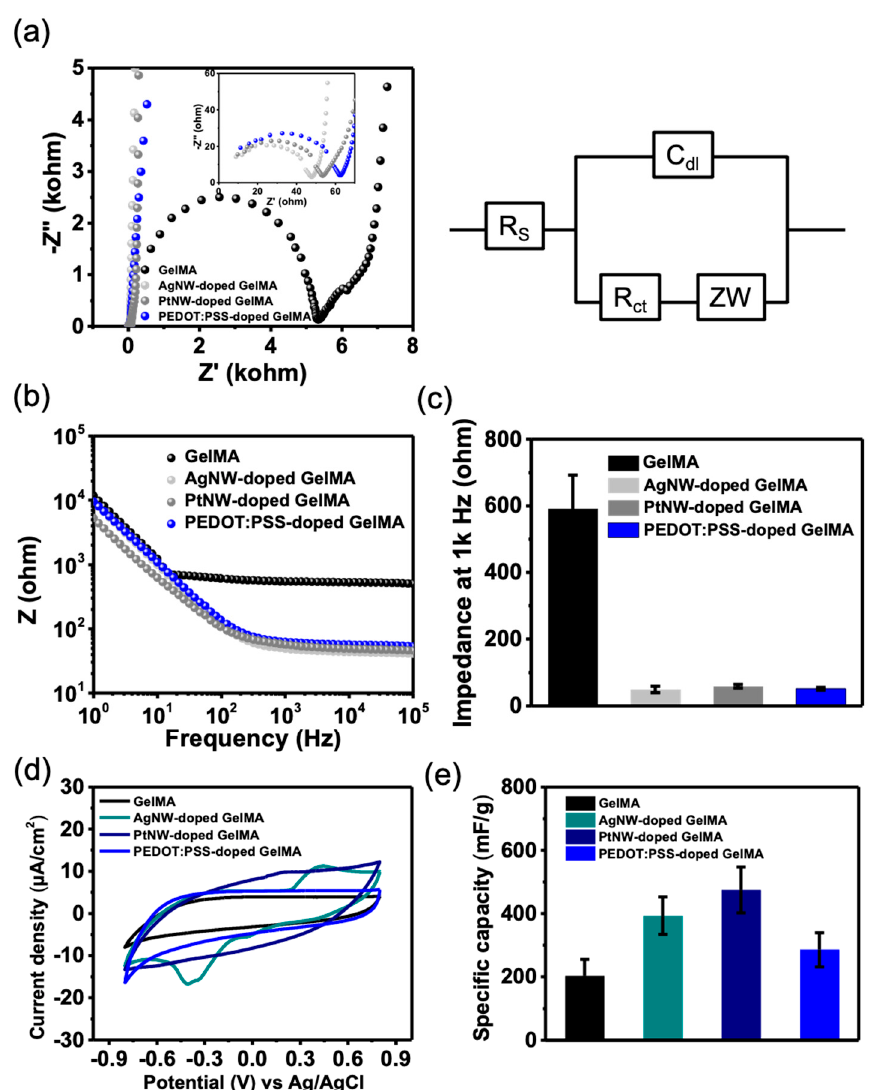
Figure 3. Electrochemical properties of NP-doped GelMA. ( a ) Nyquist diagram and the correspond- ing equilibrium circuit model. ( b ) Bode plot showing the impedance modulus over frequencies. ( c ) The impedance values at 1 kHz. ( d , e ) The CV curves and the calculated specific capacity of the hy- drogels.